Question: What kind of plot is shown here?
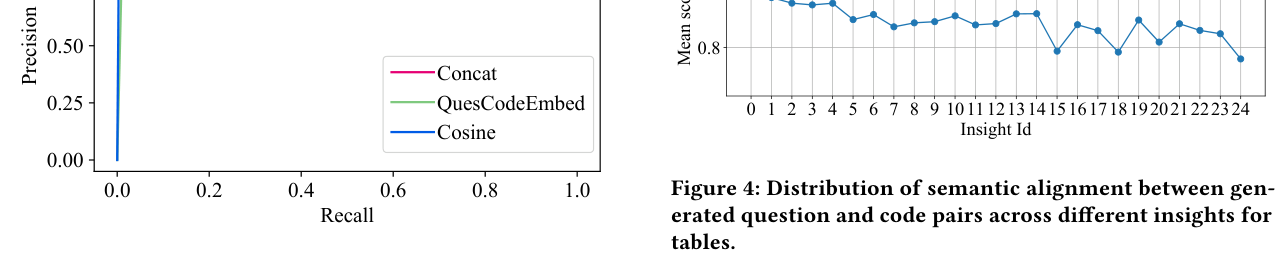
Answer: line